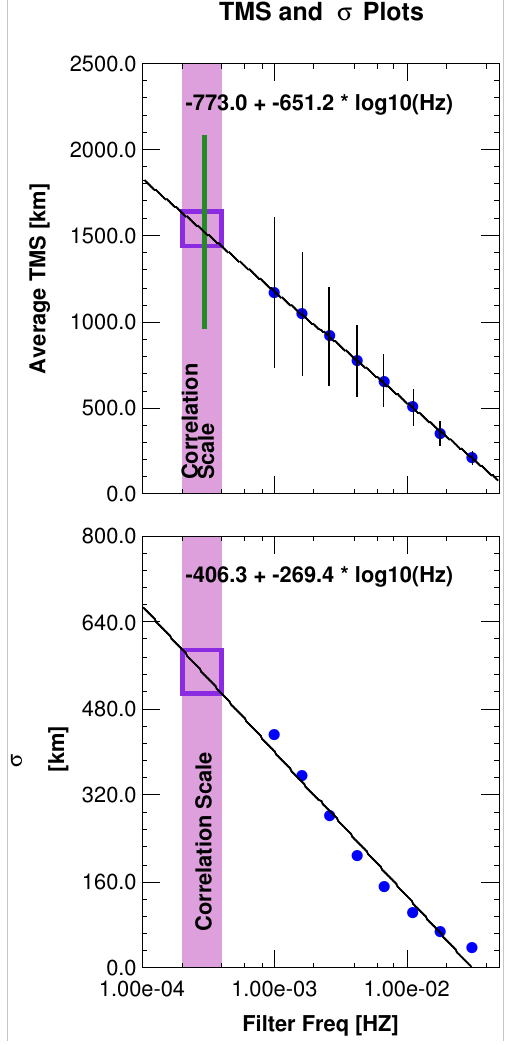
Fig. 7. λ T and corresponding standard deviation as a function of filter frequency (or equivalently the scale length). The linear rela- tionship is used to project λ T back to the correlation scale (purple band).